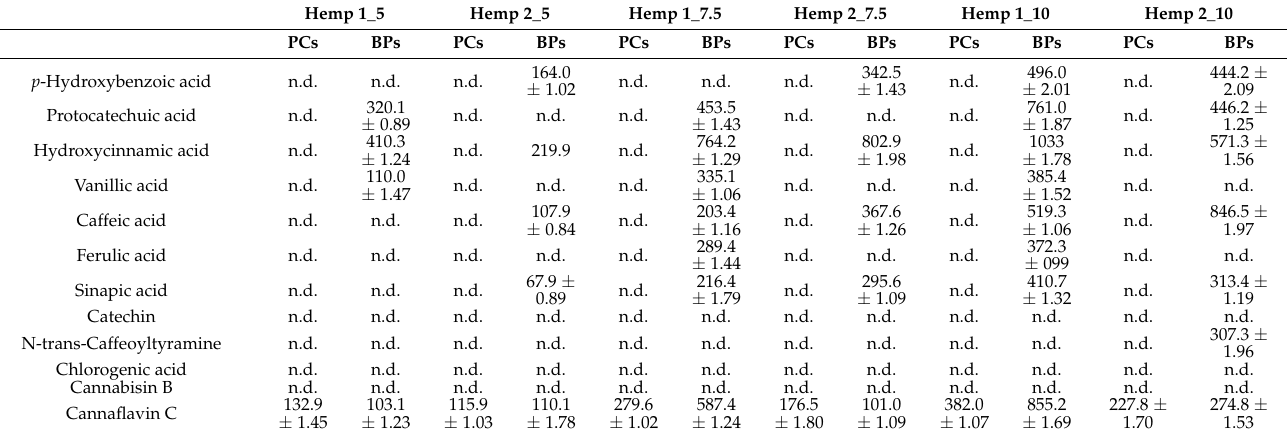
Table 7. Phenolic compounds ( µ g 100 g − 1 ): free and bound quantification in cooked pasta (PCs and BPs).